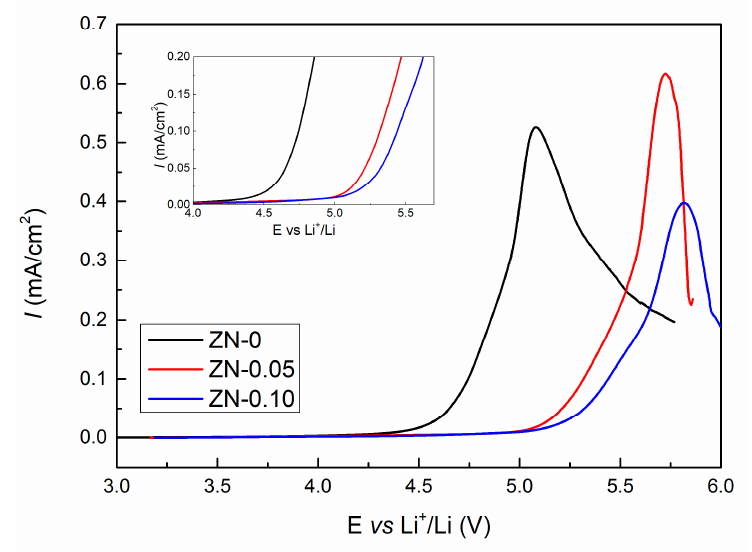
Figure 5. Linear sweep voltammograms of three-electrode cells with LiTFSI / PEGDM electrolytes containing various amount of ZN zwitterion. Testing conditions: 25 ◦ C; scan rate 1 mV s − 1 ; counter and reference electrodes—Li metal (50 µ m); working electrode—polished stainless steel. The inset is a zoom in between current 0 and 0.2 mA cm − 2 .